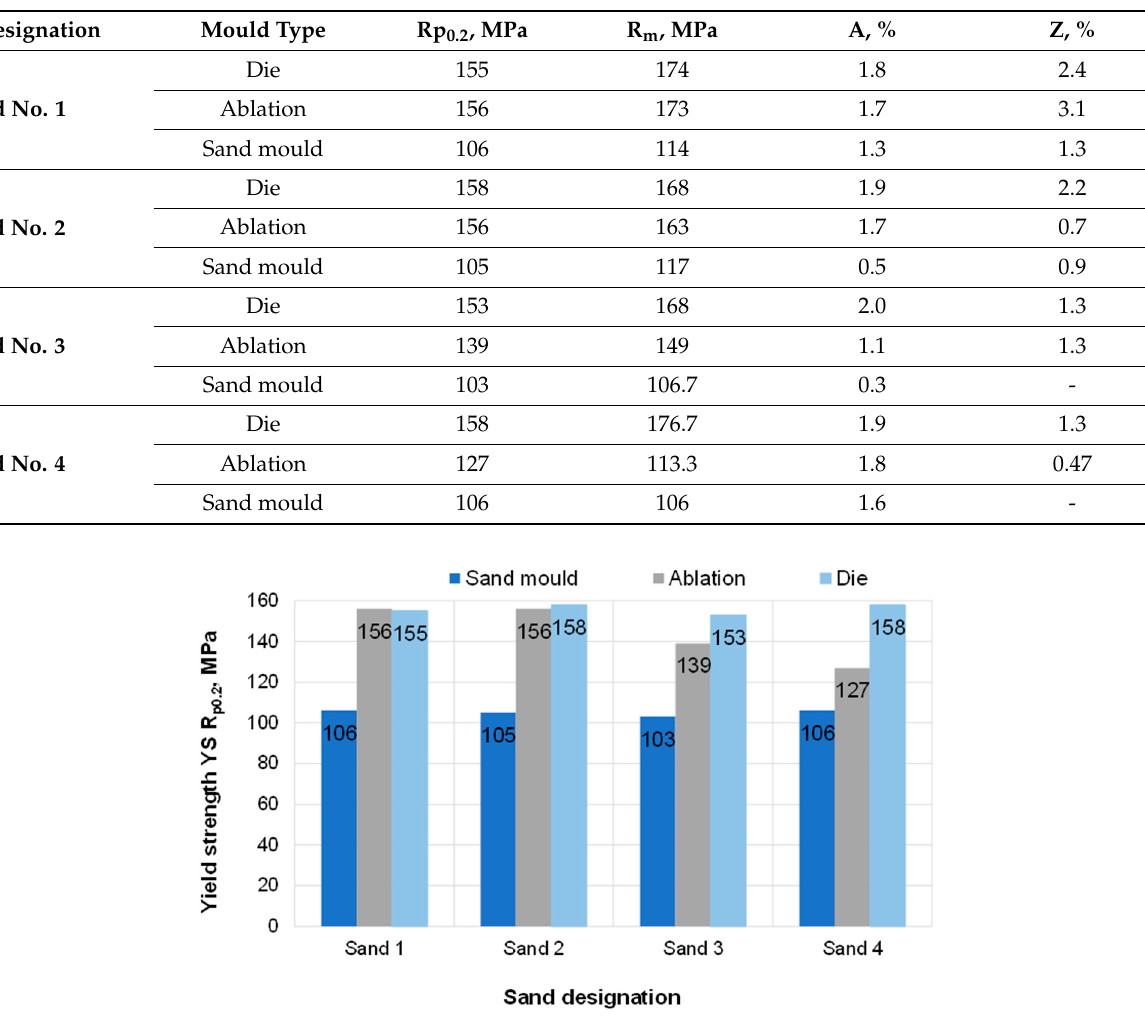
Figure 10. Yield strength Rp 0.2 of the tested samples.